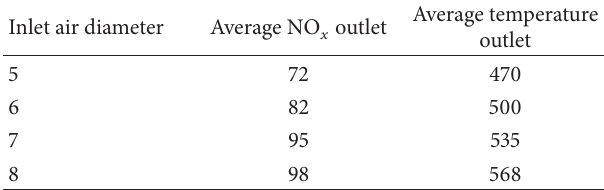
Table 2: Average outlet quantity of chamber.